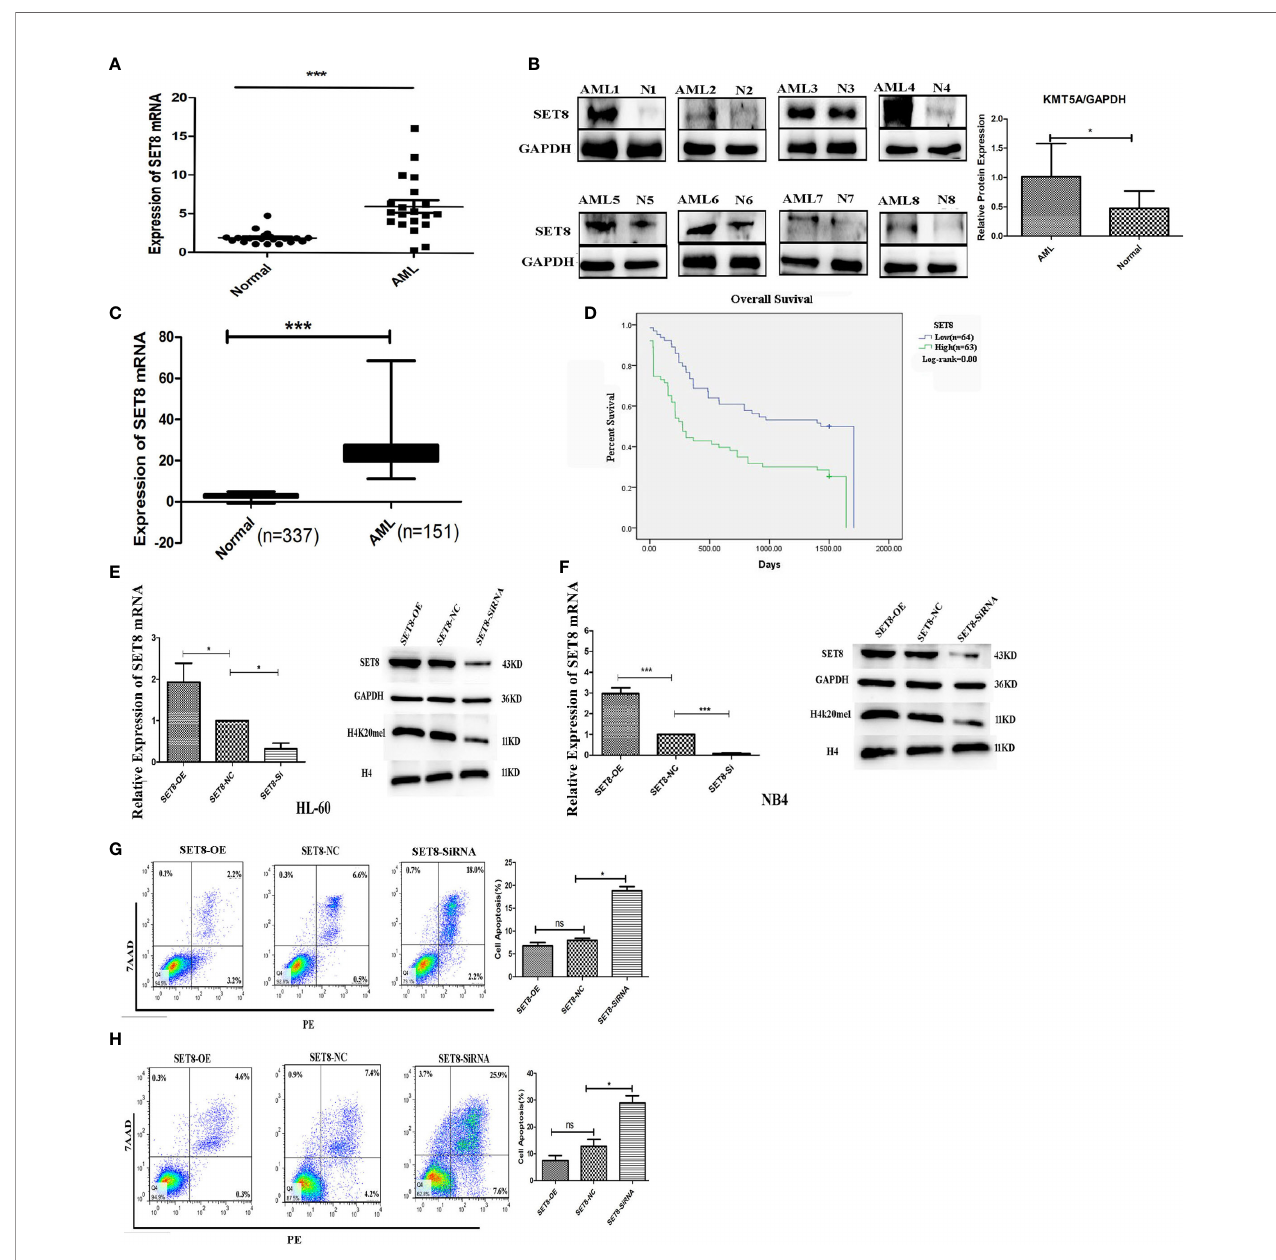
FIGURE 3 | SET8 is highly expressed in acute myeloid leukemia (AML) and is associated with poor prognosis. (A) SET8 mRNA expression in AML patients and healthy control subjects. (B) SET8 protein expression in AML patients. (C, D) The Cancer Genome Atlas and Genotype-Tissue Expression database analyses of SET8 expression between AML patients and healthy individuals. (E, F) Relative expression of SET8 and H4K20me1 in cells (HL-60 and NB4) transduced with a lentiviral vector determined through quantitative real-time PCR and Western blotting. (G, H) Flow cytometric analysis of Annexin V-PE/7-AAD staining shows that the knockdown of SET8 expression with siRNA induced apoptosis in HL-60 and NB4 cells. ns, not signi fi cant; *p < 0.05; ***p <